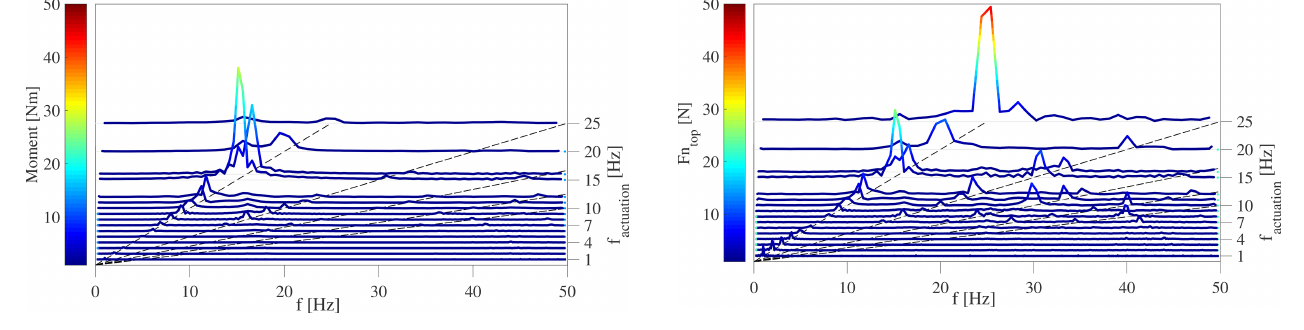
Figure 4. Waterfall diagram of the moment at different actuation frequencies for the trailing-edge flap ( y axis). The experiment was conducted with the tunnel speed set to u ∞ = 15m / s.